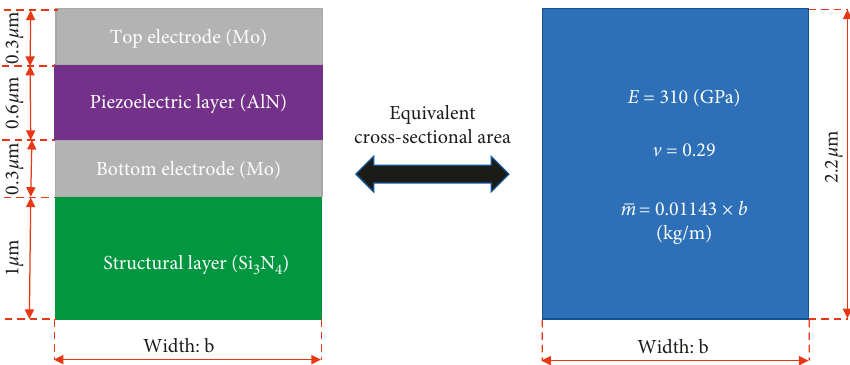
Figure 5: Different layers of the main buckled beam and its equivalent cross-sectional area parameters. Table 1: First five natural frequencies obtained for the MEMS-scale bistable energy